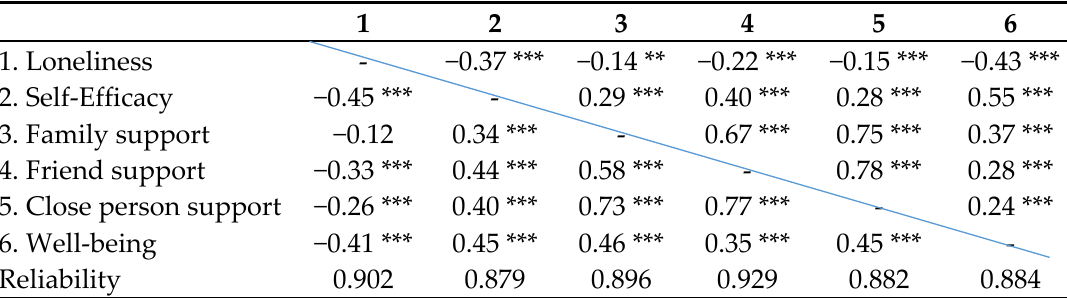
Table 2. Correlations across research items.